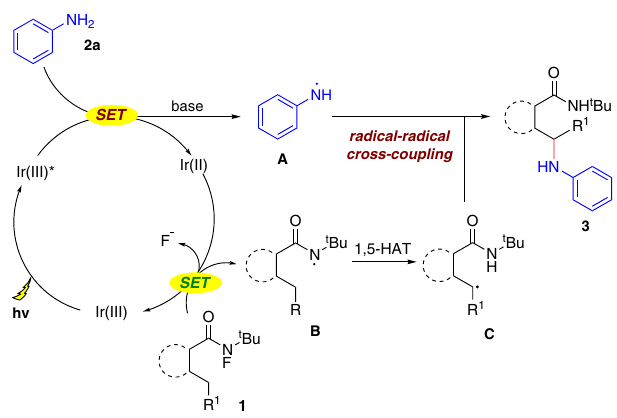
Fig. 9 Proposed mechanism. Proposed mechanism for photoinduced C (sp 3 ) – N coupling